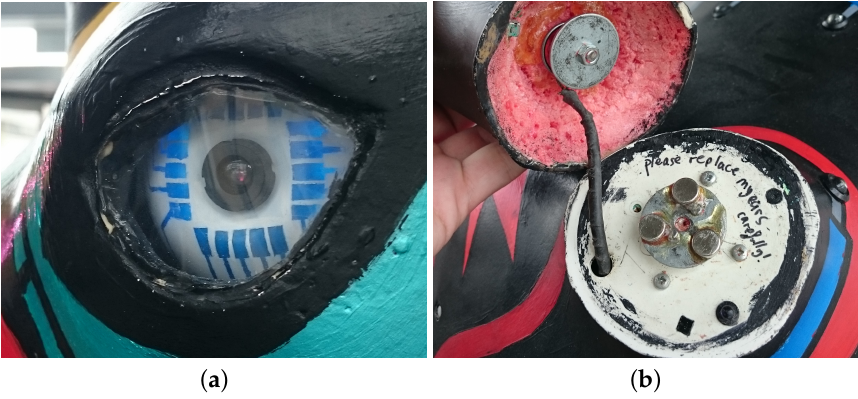
Figure 4. ( a ) detail of Erica’s eye assembly; ( b ) detail of Erica’s detachable